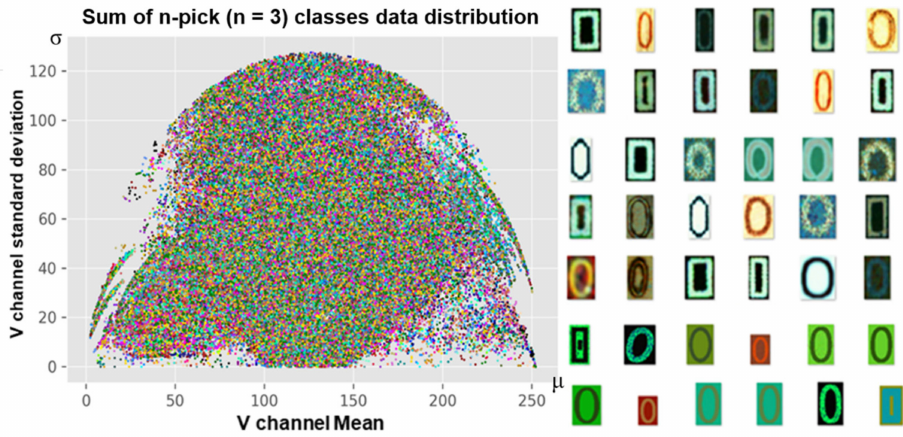
Figure 15. Visualization of distribution for all classes of the n-Pick (n = 3) dataset and an example of sampled data of class